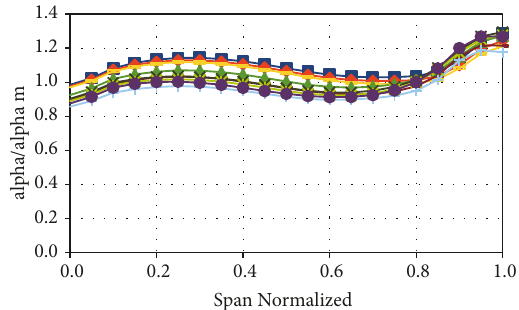
Figure 13: Flow angle/mean flow angle vs span at rotor inlet section for different rotational speed, partial shroud admission.